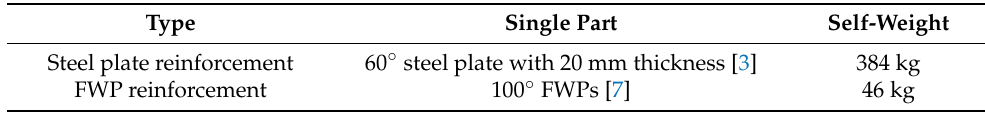
Table 1. The comparison of single parts’ self-weight between steel plate reinforcement and FWP